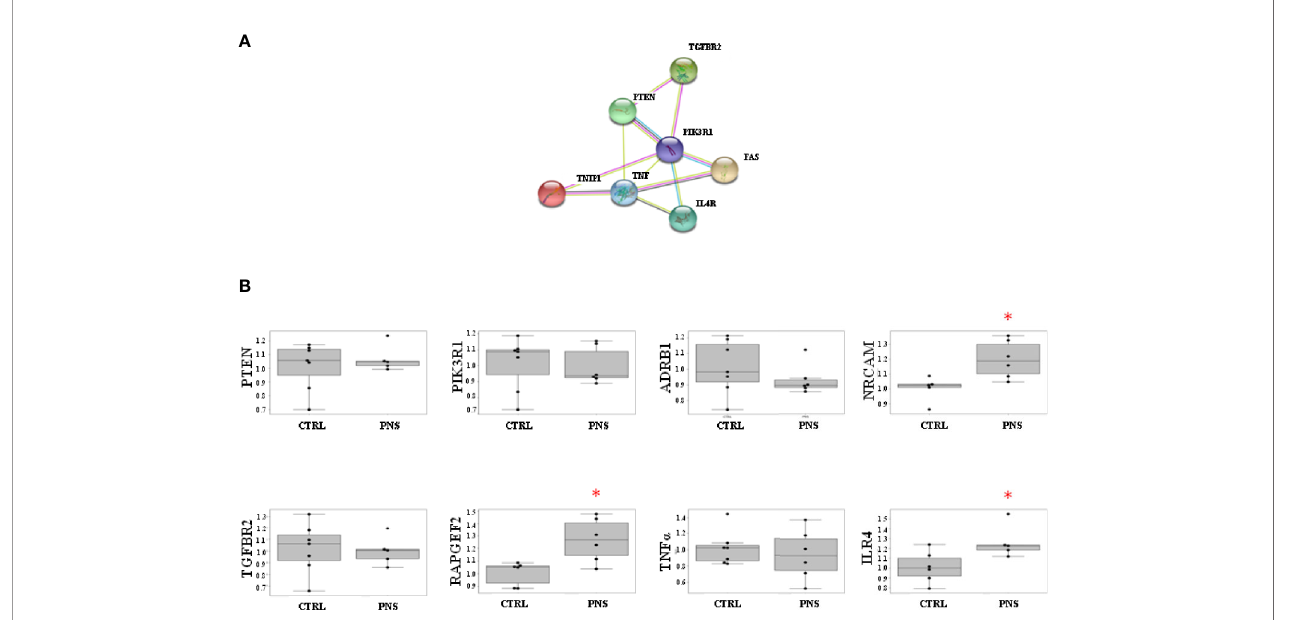
FIGURE 3 | (A) STRING protein-protein interactions between validated target genes of miR-19 selected for Real-Time PCR analyses. The protein-protein interaction analysis shows an enrichment of interactions with TWAS genes involved in neurodevelopmental and in fl ammatory processes (p-value = 0.67E-04), and is corroborated by the presence of a sub-cluster of such genes with at multiple levels of interactions evidences. (B) Effects of PNS on validated target genes of miR- 19a and miR-19b in adult PNS rats (PND 62) as compared to control animals. PNS signi fi cantly upregulates the expression levels of NRCAM, IL4R, and RAPGEF2. Data are shown using boxplot; *p <